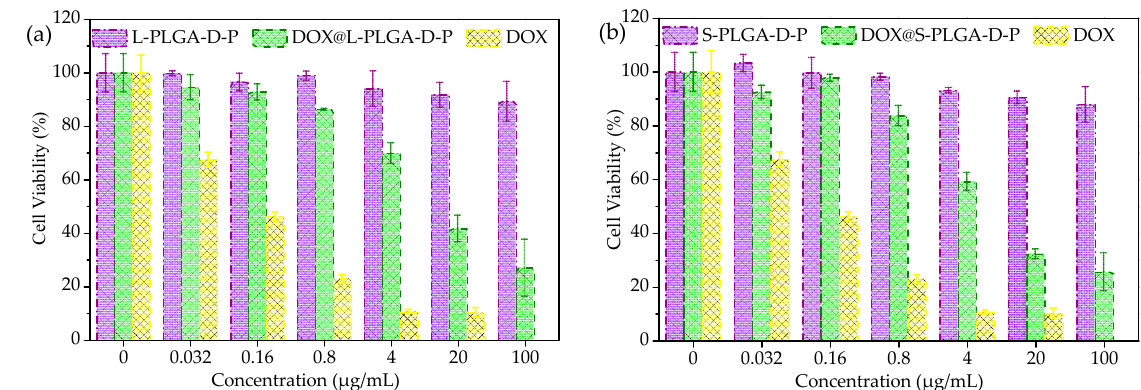
Figure 9. Viability of MCF-7 cells cultured with ( a ) L-PLGA-D-P, DOX@L-PLGA-D-P, free DOX and ( b ) S-PLGA-D-P, DOX@S-PLGA-D-P, free DOX for 48 h incubation.